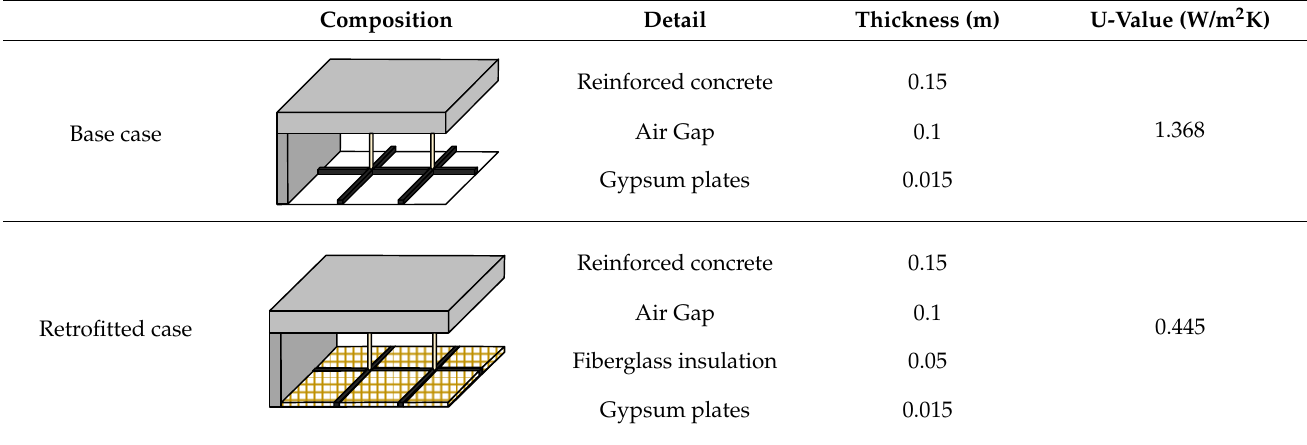
Table 8. Composition of material and thermal transmittance of the roof in the case-study building.